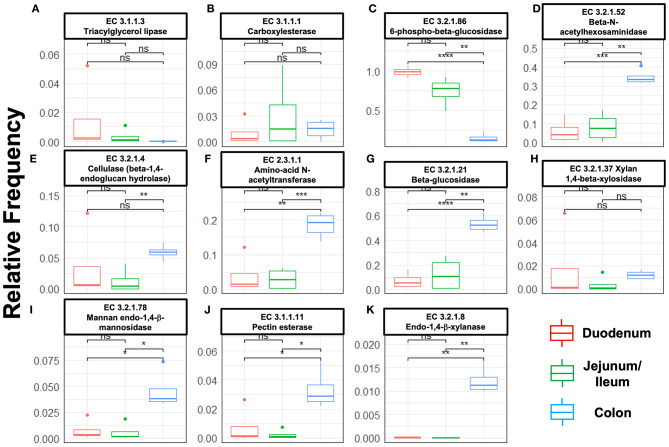
Species relative frequencies of bacteria producing the following enzymes in duodenum, jejunum/ileum, and large intestine of hemophilia B mice as predicted by PICRUSt2 on different 16S rRNA variable region taxonomic profiles. Results are shown for six variable regions analyzed by NGS (Statistical method t-test was used, asterisks represent significance level of a pairwise t-test with P-values i.e., ‘****' ≤ 1e-04, ‘***' ≤ 0.001, ‘**' ≤ 0.01, ‘*' ≤ 0.05, ns > 0.05 (not significant). (A) Triacylglycerol lipase. (B) Carboxylesterase. (C) 6-phospho-β-glucosidase. (D) β-N-acetylhexosaminidase. (E) Cellulase (β-1,4-endoglucan hydrolase). (F) Amino-acid N-acetyltransferase. (G) β-glucosidase. (H) Xylan 1,4-β-xylosidase. (I) Mannan endo-1,4-β-mannosidase. (J) Pectinesterase. (K) Endo-1,4-β-xylanase.